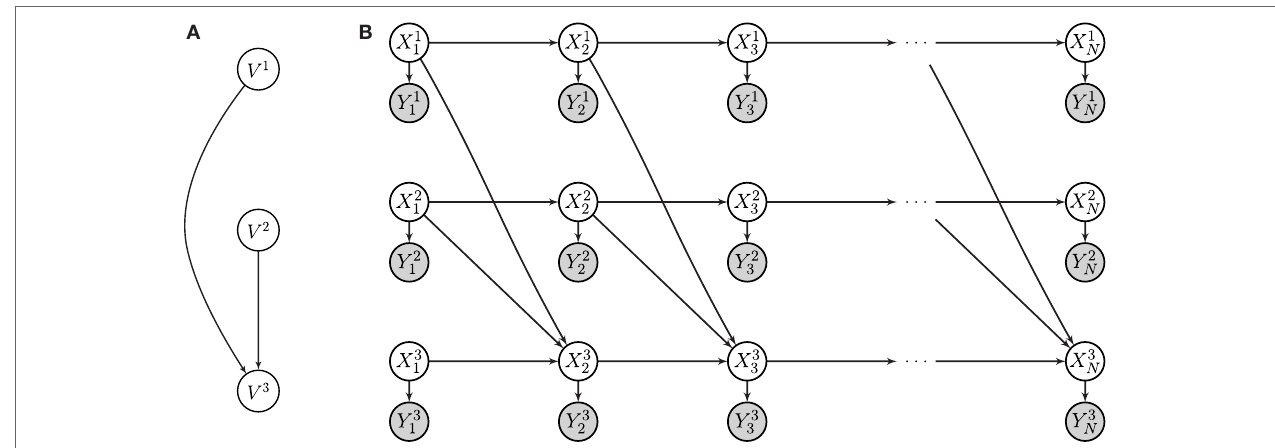
FIGURE 1 | Representation of (A) the synchronous GDS with three vertices ( V 1 , V 2 and V 3 ), and (B) the rolled-out DBN of the equivalent structure . Subsystem V 3 is coupled to both subsystems V 1 and V 2 by means of the edges between latent variables X 1 n ! X 3 n + 1 and X 2 n ! X 3 n + 1 .